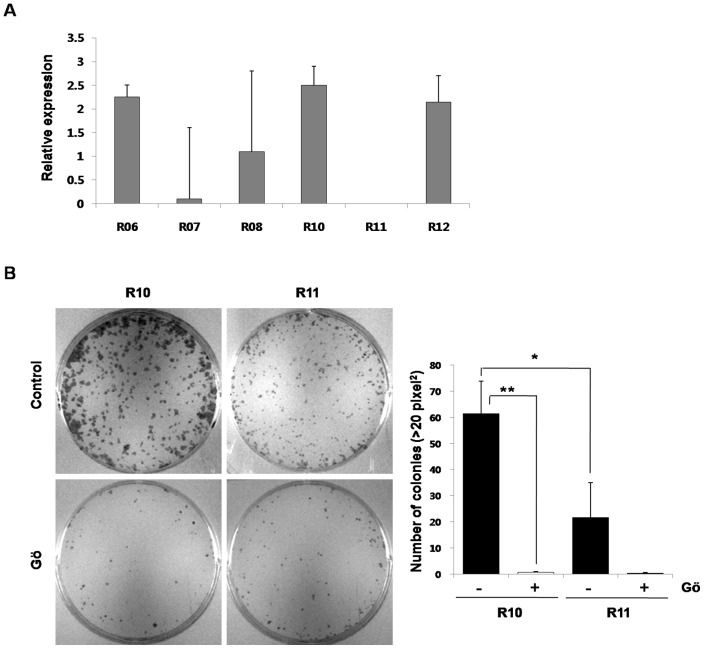
CSC induced the expression of Wnt5a and increased colony forming capacity in non-CSC exposed 1799 cells.(A) 1799 cells treated with 10% CSC for 8 days and further cultured in normal growth medium. CSC-transformed clones of 1799 cells were isolated and used to profile the expression of Wnt5a using quantitative RT-PCR. (B) Selected R10 and R11 clones were examined for the colony-forming efficiency with or without a PKC inhibitor (Gö: 2.5 µM Gö6o76). Colonies were fixed in methanol and stained with 0.1% crystal violet. The data are representative of three experiments. Quantification of data means the average number of colonies (>20 pixel2) per dish from the triplicate. Bars denote standard error. Significant differences (*: p<0.05, **: p<0.005) from control as determined by a Student's t test.